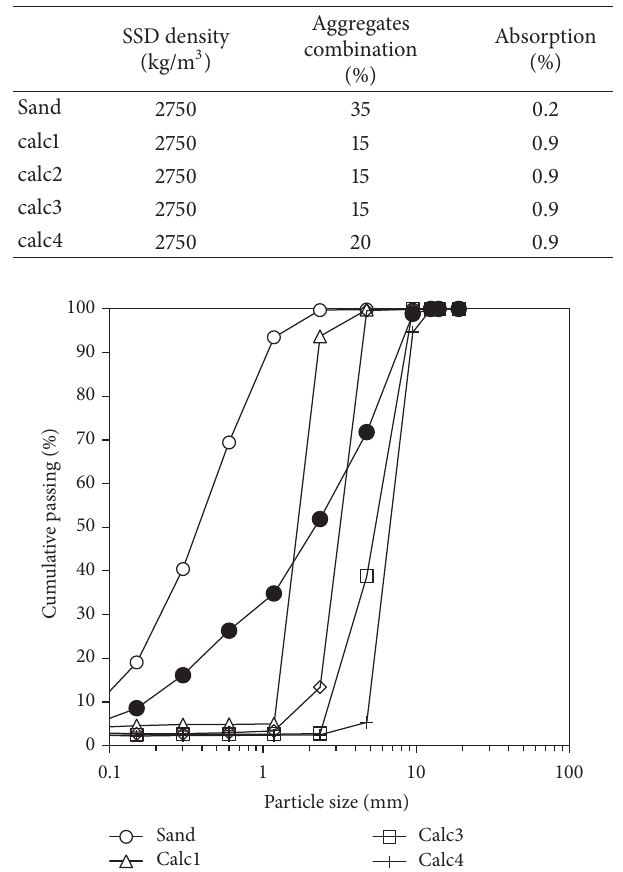
Table1:SSDdensity,fractionofcombination,andabsorptionoffive classes of aggregates.